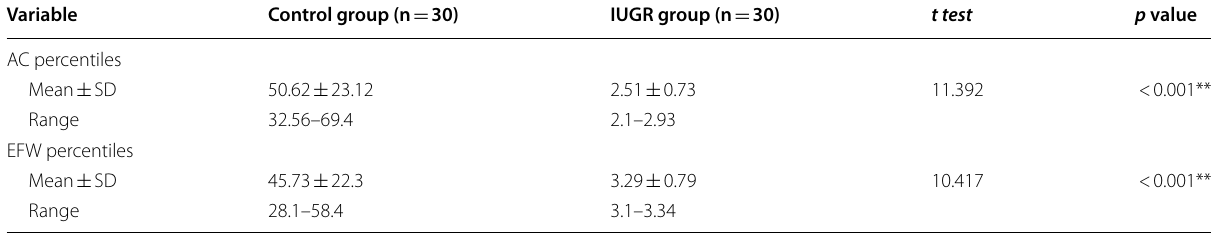
t , Independent Sample t test